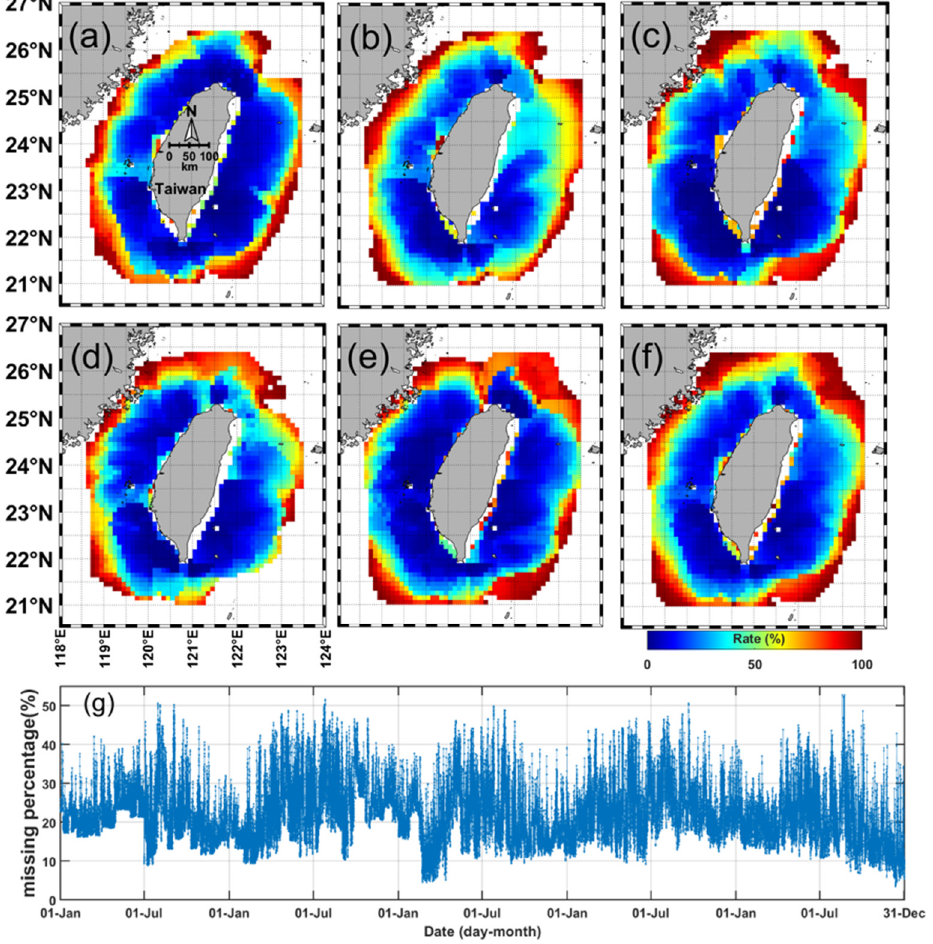
Figure 2. The spatial missing data rate in year of ( a ) 2015, ( b ) 2016, ( c ) 2017, ( d ) 2018, ( e ) 2019, and ( f ) 2015–2019, and ( g ) the temporal missing data rate in 2015–2019.